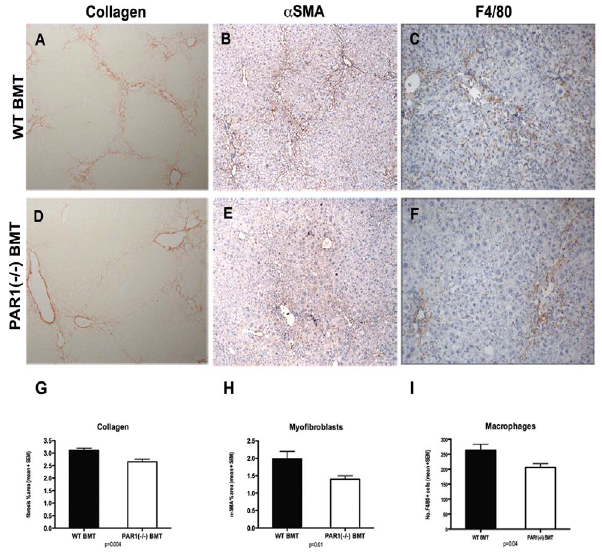
Figure 5. Absence of PAR1 signalling on BM-derived cells can confer protection against liver fibrosis. C57/BL6 WT mice transplanted with BM from PAR1 knockout donors (PAR1( 2 / 2 )BMT, D–F) acquired significantly less hepatic collagen (images A&D, sirius red, 6 100; graph G), fewer activated myofibroblasts (images B&E, a SMA, brown, 6 100; graph H) and fewer hepatic macrophages (images C&F, F4/80, brown, 6 200; graph I) after CCl 4 injury compared to control mice transplanted with WT BM from C57/BL6 donors (WTBMT, A–C). (graphs show mean + SEM, p values as shown.)